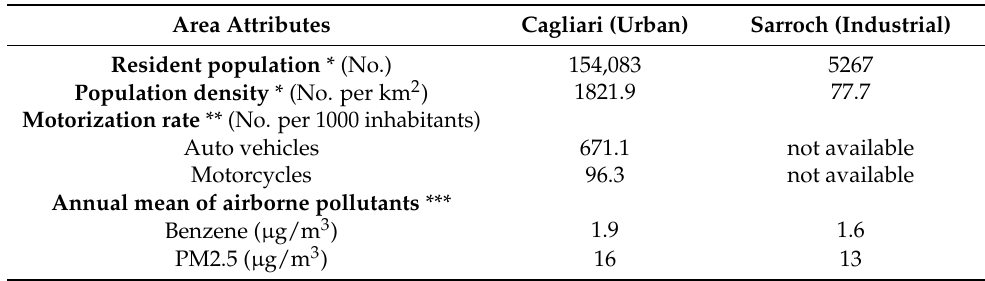
Table 1. Resident population, motorization rate, and annual mean airborne level of benzene and PM2.5 in the two study